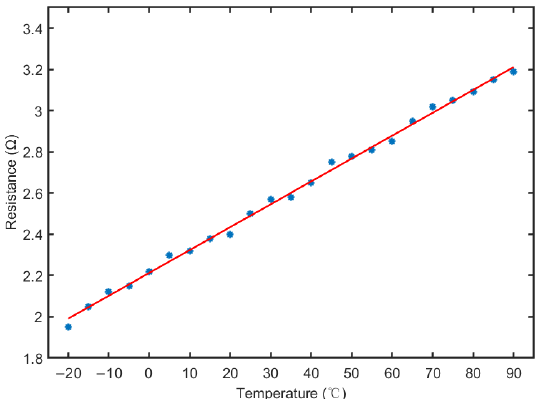
Figure 2. Resistance value and fitting curve of MRD at different working temperatures.